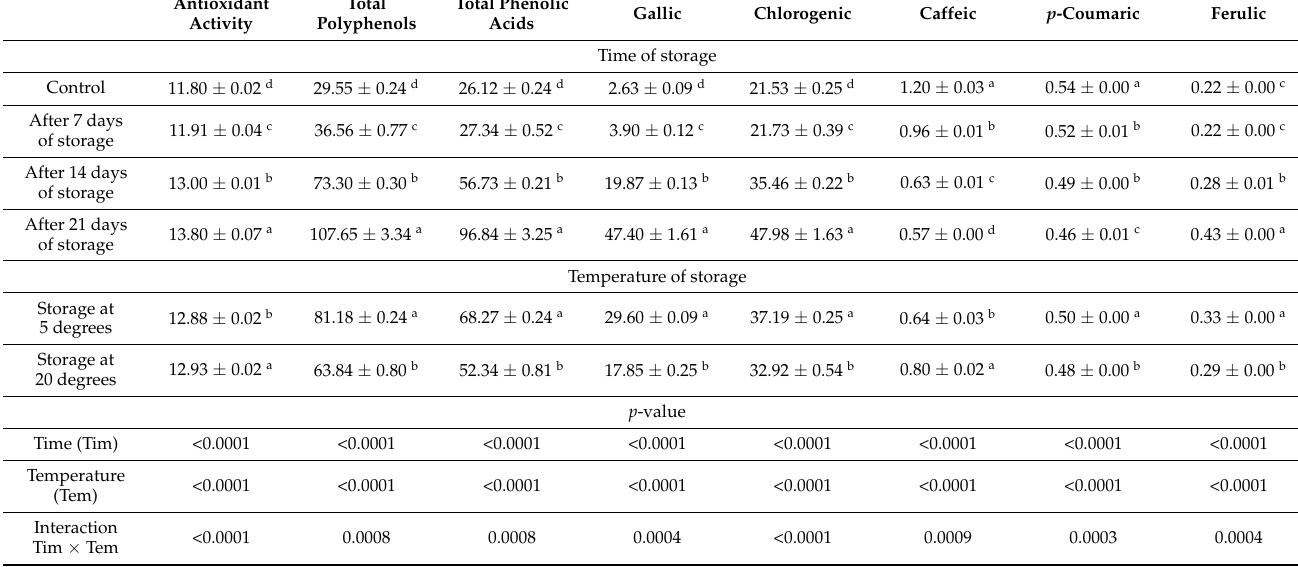
Table 4. The antioxidant activity (in µ M TEAC/1 g) and the content of total polyphenols and individually identified phenolic acids in apple (in mg/100 g